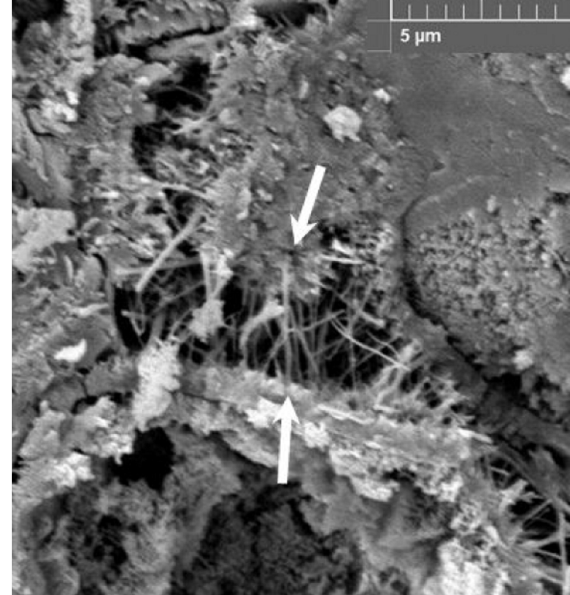
Figure 9. Micrograph of the failure surface of [PM+SNF+MWCNT] sample. The arrows indicate the links of MWCNT with the matrix material.